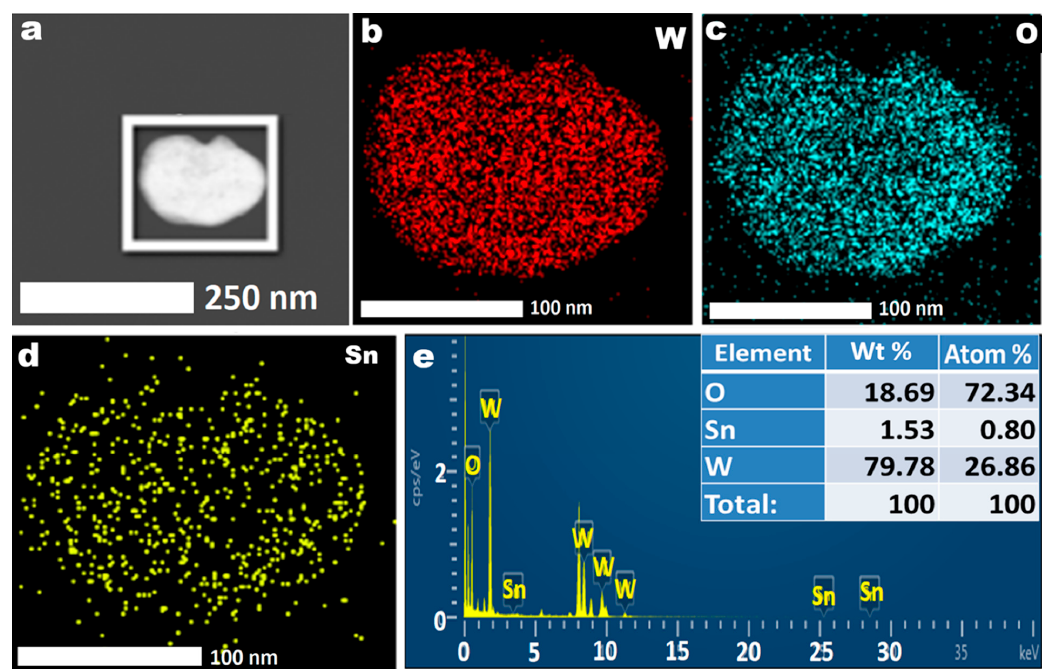
Figure 4. ( a ) Scanning transmission electron microscopy (STEM) image showing the selected area of Sn-doped WO 3 nanoparticle and elemental mapping indicating the distribution of ( b ) W, ( c ) O, and ( d ) Sn. ( e ) EDS graph and the inset table show the quantitative values of elements present in the Sn- doped WO 3 nanoparticle.